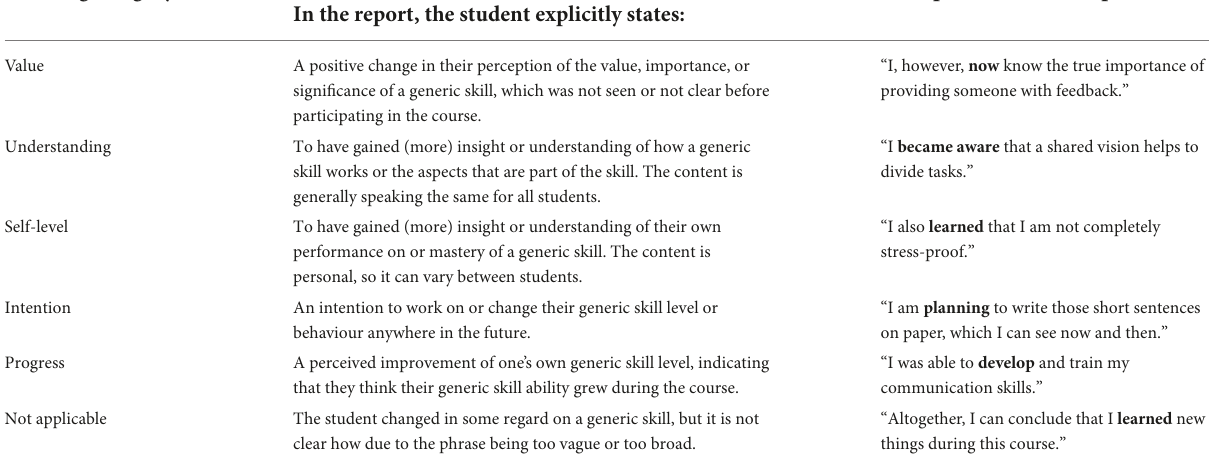
TABLE 1 Learning categories , their definitions, and examples, with indication words in bold. Learning